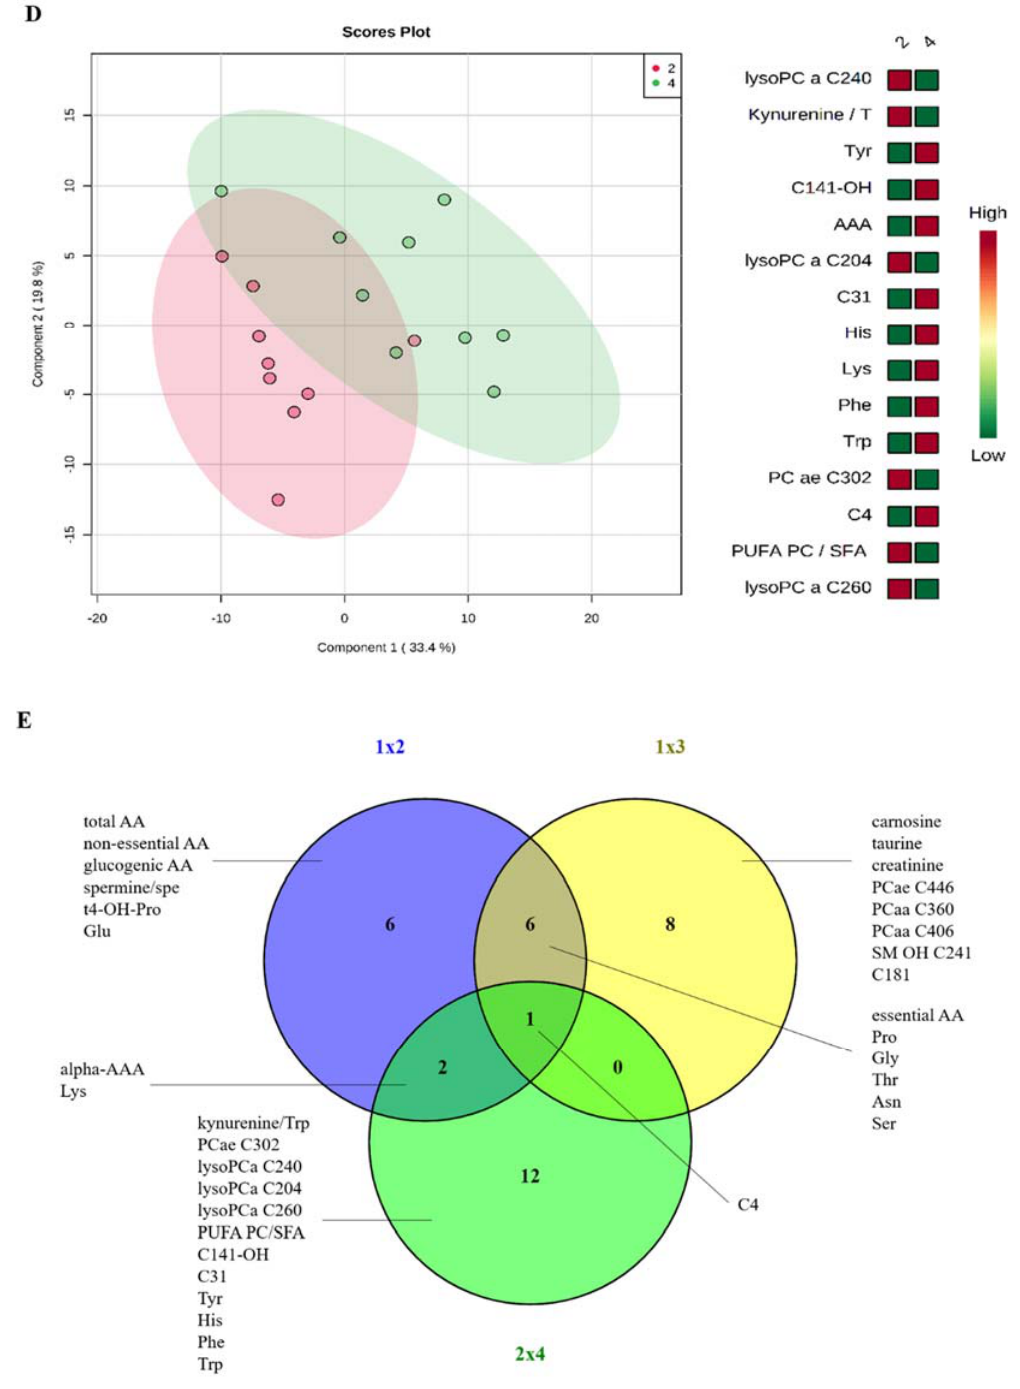
Figure 4. Multivariate analyses of metabolome of HEK-293T in conditioned media. ( A ) Partial least squares discriminant analysis (PLS-DA) scores plot of multivariate analysis of all conditions 1–4 showing di ff ering clusters. 1: NT CM / NT cells, 2: NT CM / TDP-43 cells, 3: TDP-43 CM / NT cells, and 4: TDP-43 CM / NT cells. ( B ) NT CM / NT cells (1) vs. NT CM / TDP-43 cells (2). Left: PLS-DA scores plot. Right: Corresponding top 15 VIP metabolites. ( C ) NT CM / NT cells (1) vs. TDP-43 CM / NT cells (3). Left: PLS-DA scores plot. Right: Corresponding top 15 VIP metabolites. ( D ) NT CM / TDP-43 cells (2) vs. TDP-43 CM / TDP-43 cells (4). Left: PLS-DA scores plot. Right: Corresponding top 15 VIP metabolites. ( E ) Venn diagram of VIP metabolites of all conditions. N = 3 for all analyses. Metabolomics analyses were realized with MetaboAnalyst (http://www.metaboanalyst.ca).